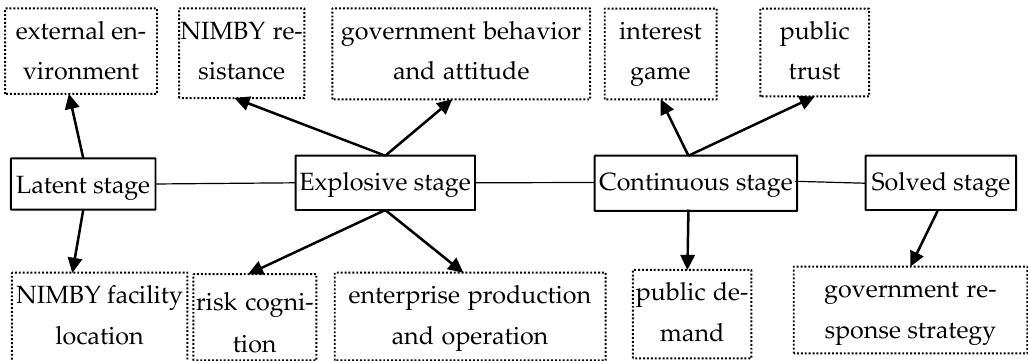
Figure 2. Scenario evolution factors of waste NIMBY (Not-In-My-Back Yard) crisis.